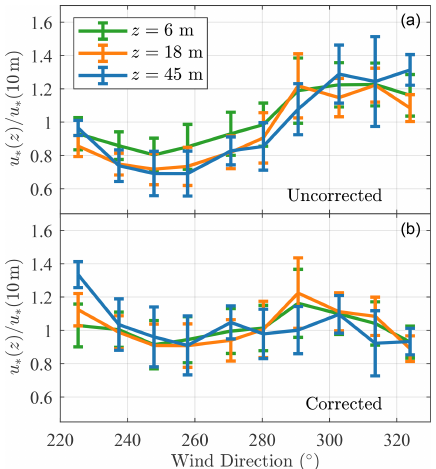
Figure B1. Ratio of the friction velocity by the omnidirectional so- lent anemometers to the one estimated at 10m (asymmetric solent anemometer) before (a) and after (b) correction using a multivari- ate regression analysis. Velocity data recorded between May and September 1994 for the sector 220–330 ◦ were used (480 samples of 30min duration), and | z/L | < 2 at